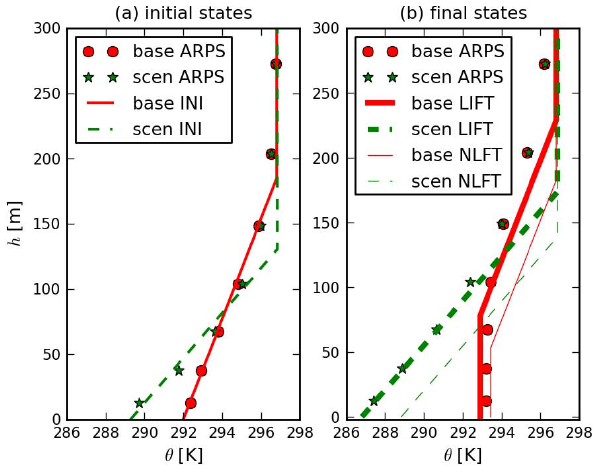
Fig. 12. Vertical potential temperature profiles from ARPS and from idealized boundary-layer advection models. h indicates the height above ground level. The initial (22:00UTC, 6.3km upwind) and final states (23:00UTC, 6.3km downwind) are plotted on (a) and (b) , respectively. In both panels, the profiles from the ARPS output are indicated with red circles and green stars for the base run and scenario run, respectively. The full red line in (a) represents the fitted initial state for the idealized advection models for the base case (base INI), and the dashed green line that for the scenario case (scen INI). In (b) , thick lines are referring to the final states of the idealized models with orographic uplift (LIFT), and thin lines with- out orographic uplift (NLFT) for the respective